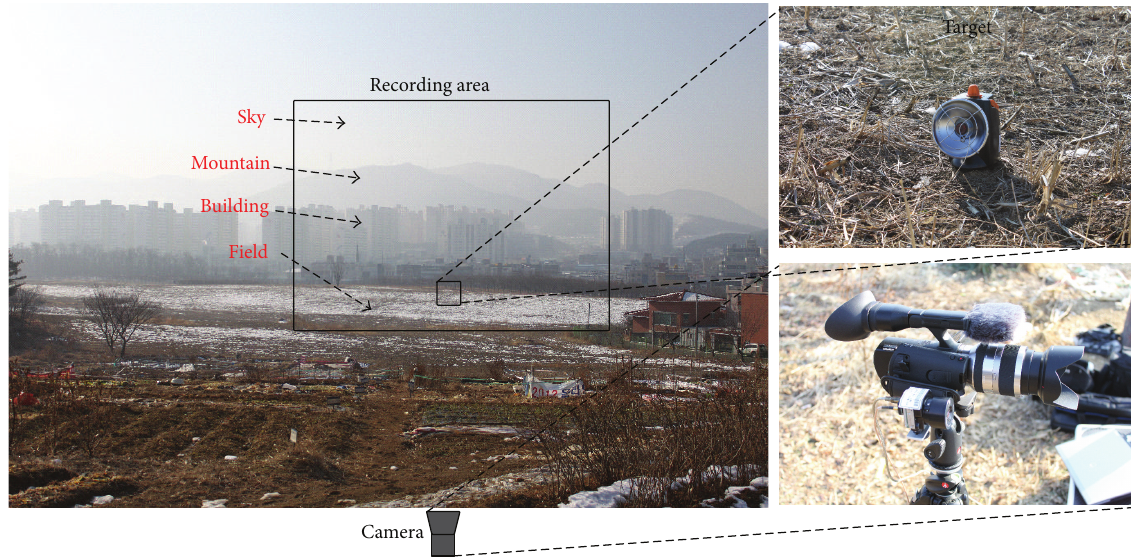
Figure 7: Recording area and locations of the target and